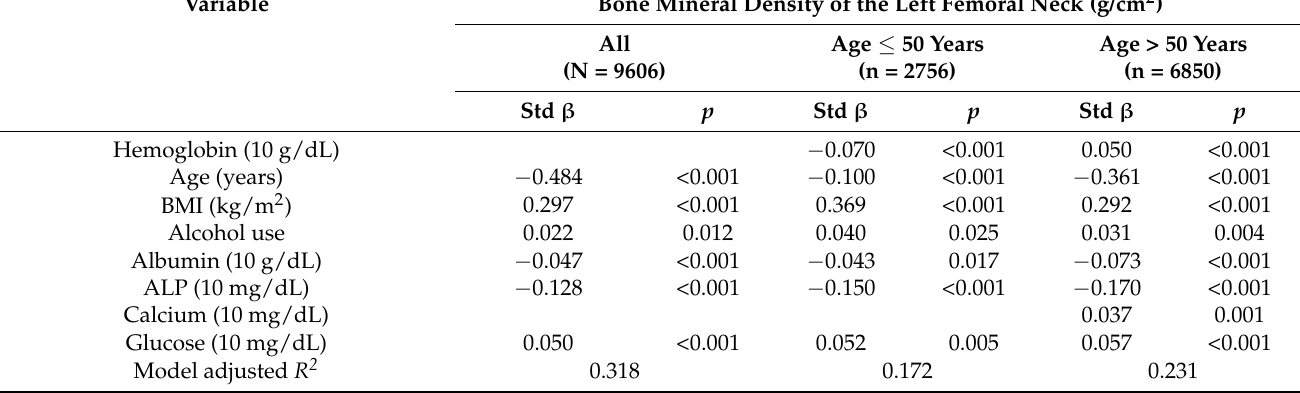
Table 8. Multiple linear regression analysis of factors associated with bone mineral density of the left femoral neck in female patients with and without stratification by age group.